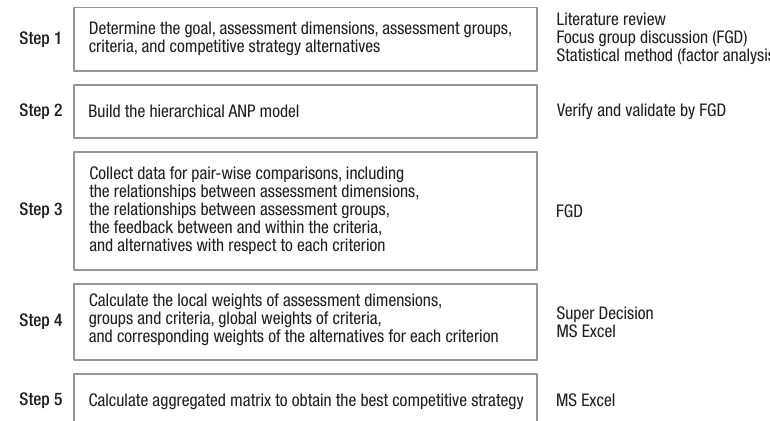
Fig. 3. The proposed research process for selecting the best competitive strategy alternative